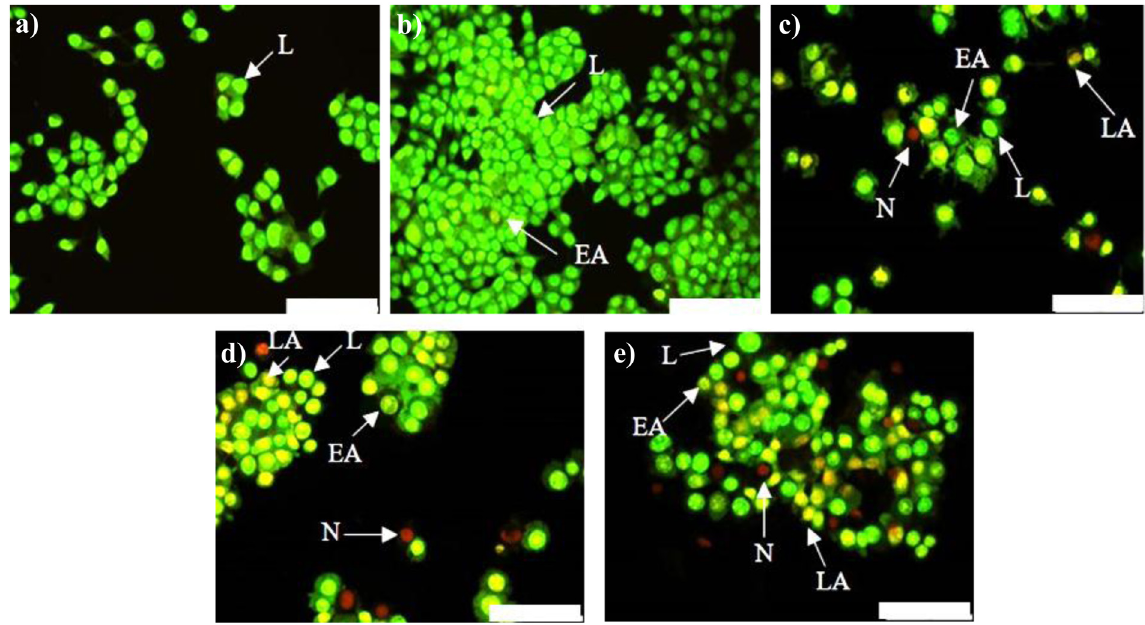
Figure 9. Apoptotic potential of anti- c-myc lipoplexes in MCF-7 cells. Cells were visualised 48 h post-transfection with AO/EtBr dual staining. a ) Control, no treatment, ( b ) naked anti- c-myc -siRNA, ( c ) LF3K:siRNA, ( d ) MS09:DOPE:siRNA and e ) MS09:Chol:siRNA. Scale Bar =